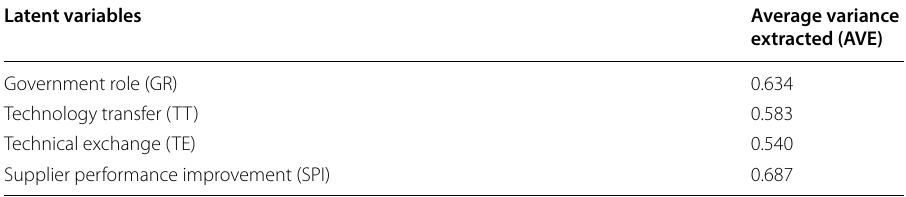
Table 5 Average variance extracted (AVE). Source : Author data, Smart PLS 3.2.7